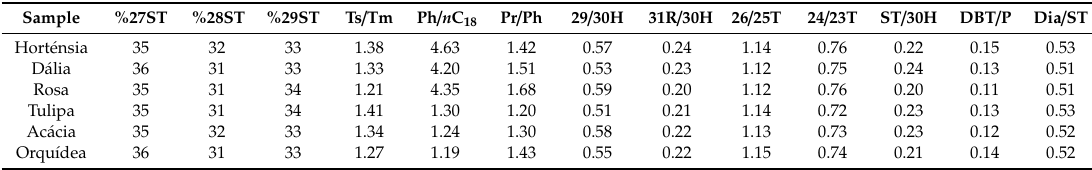
Table 2. Geochemical indicators of source type and depositional environment for saturated and aromatic fractions in oils